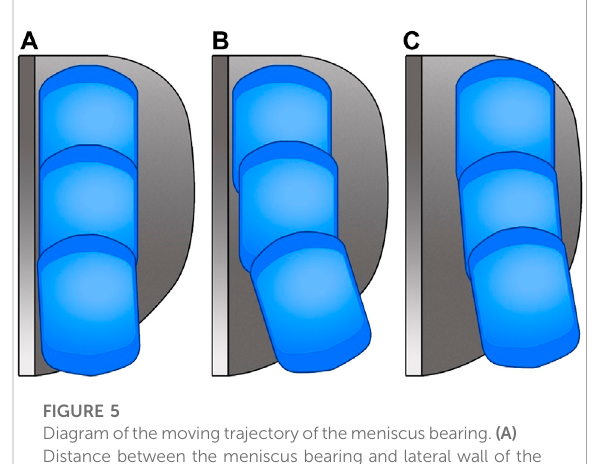
FIGURE 5 Diagramofthemovingtrajectoryofthemeniscusbearing. (A) Distance between the meniscus bearing and lateral wall of the tibial component is maintained stable within 2 mm during fl exion/ extension; (B) meniscus bearing is maintained close to the lateral wall of the tibial component during knee fl exion and kept away from the lateral wall of the tibial component during knee extension, and the horizontal distance between the meniscus bearingandthelateralwallofthetibialcomponentisover2 mmin full extension; (C) meniscus bearing is consistently kept away from the lateral wall of the tibial component during knee fl exion and knee extension. Type c was rarely seen in over study with only three